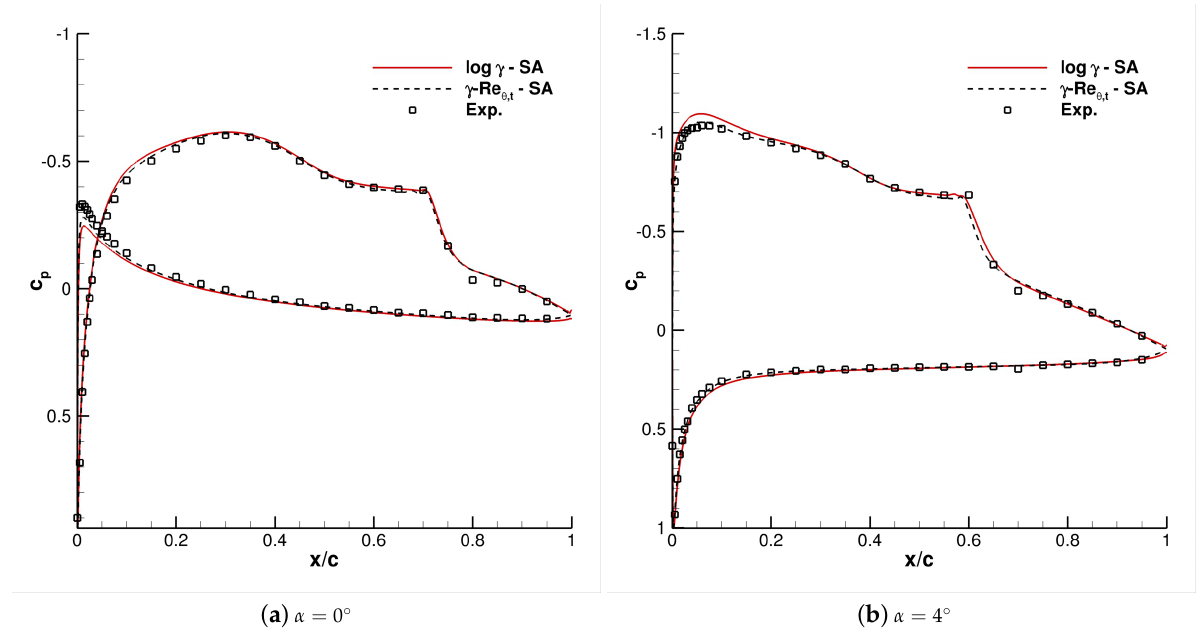
Figure 11. E387, Re = 2 × 10 5 . Pressure coefficients.